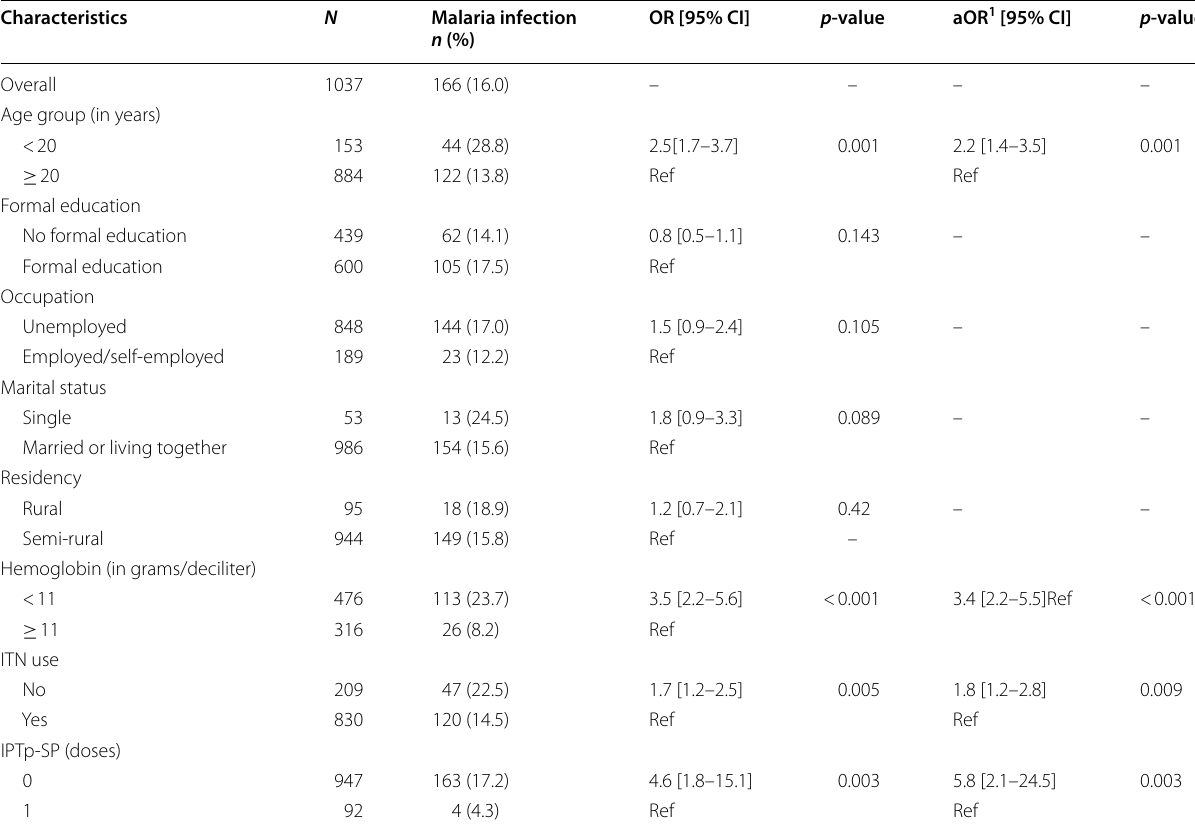
Table 3 Bivariate and multivariate analyses of factors associated with malaria infection among first ANC attendees ( n Yako health district, rural Burkina